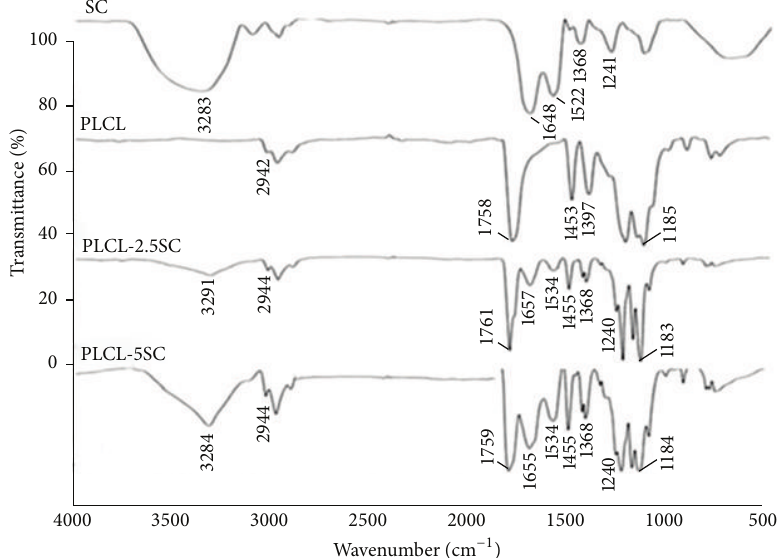
Figure 2: FT-IR spectra of (a) SC powder, (b) PLCL membrane, (c) PLCL-2.5SC, and (d) PLCL-5SC membranes. The peaks were analyzed to the functional groups as shown in Table 3.